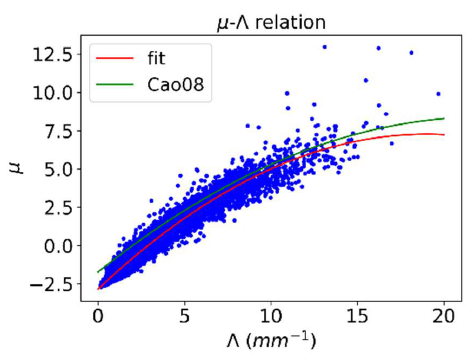
Figure 5. The  -  relation for the disdrometer data . The blue dots are the  and  Figure 5. The µ - Λ relation for the disdrometer data. The blue dots are the µ and Λ parameters obtained parameters obtained by a truncated Gamma method [8]. The red curve is a second-order polynomial by a truncated Gamma method [8]. The red curve is a second-order polynomial fit for the data, and the fit for the data, and the green curve is (7) in [63]. green curve is (7) in